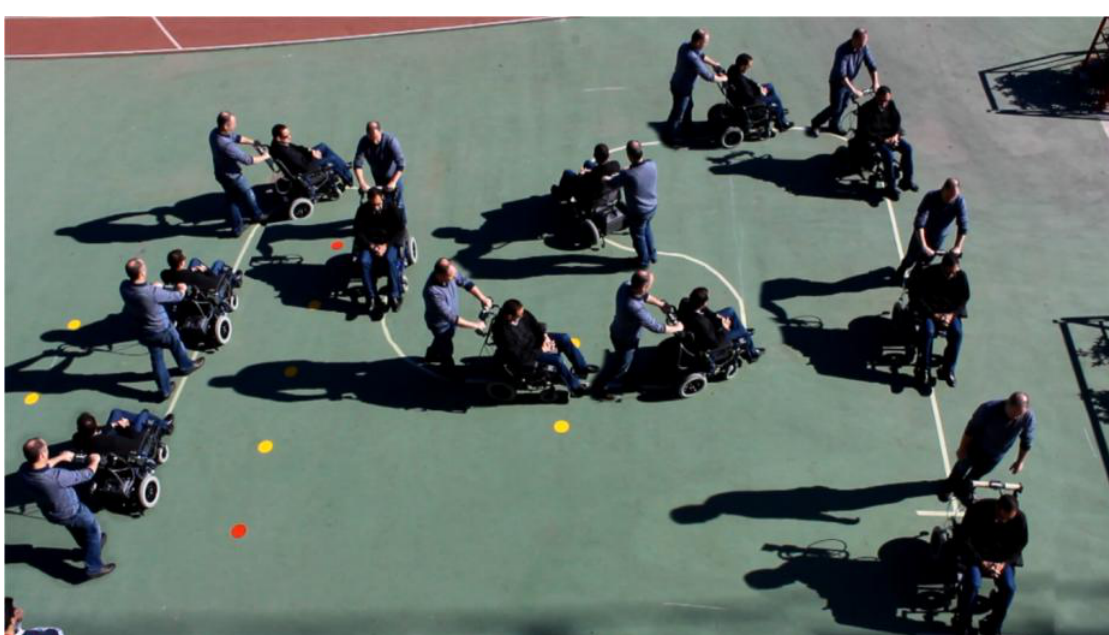
Figure 24. Test path: fifth